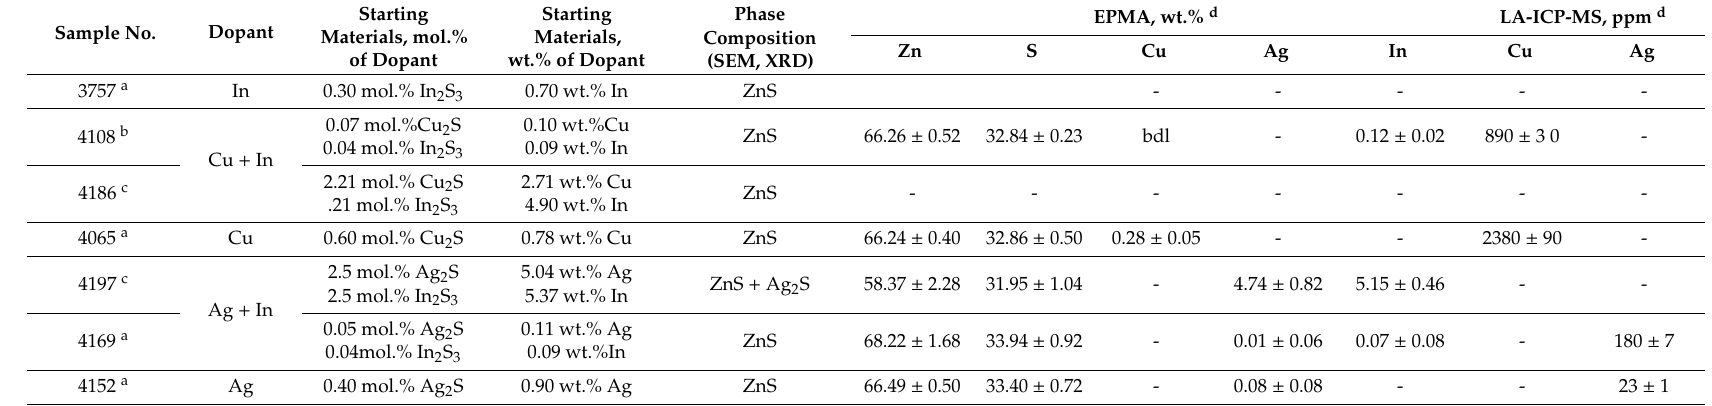
Table 1. Chemical composition of synthesized sphalerite